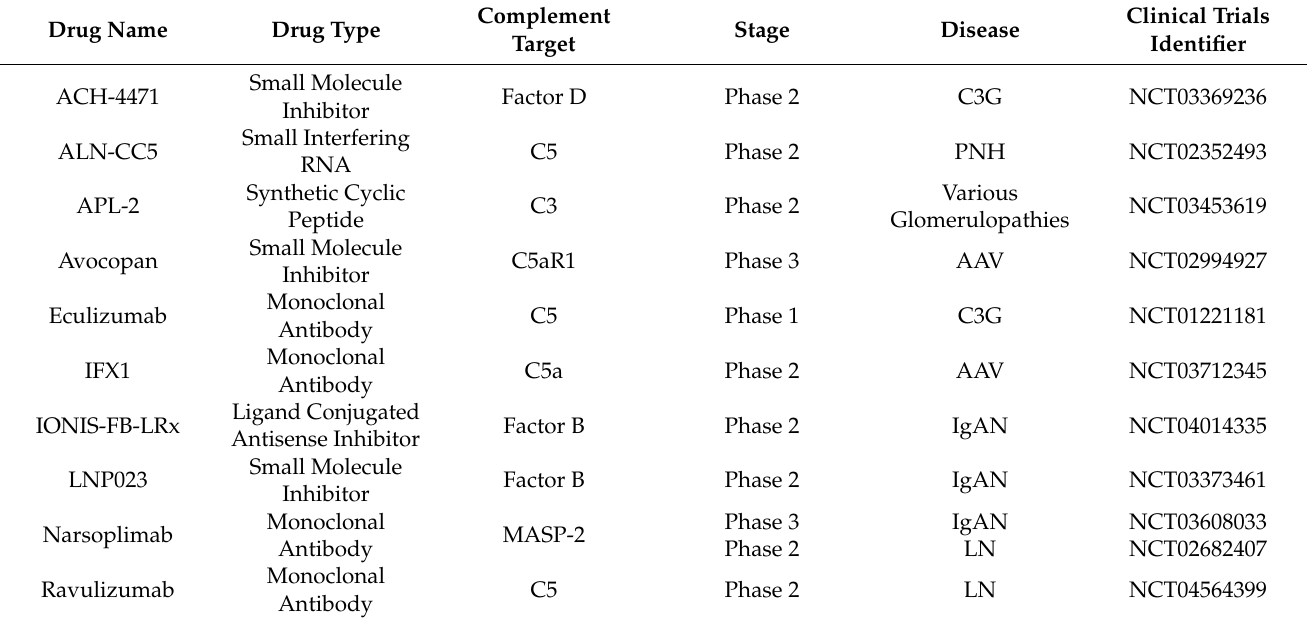
Table 1. Complement-targeted therapies in clinical trials of kidney